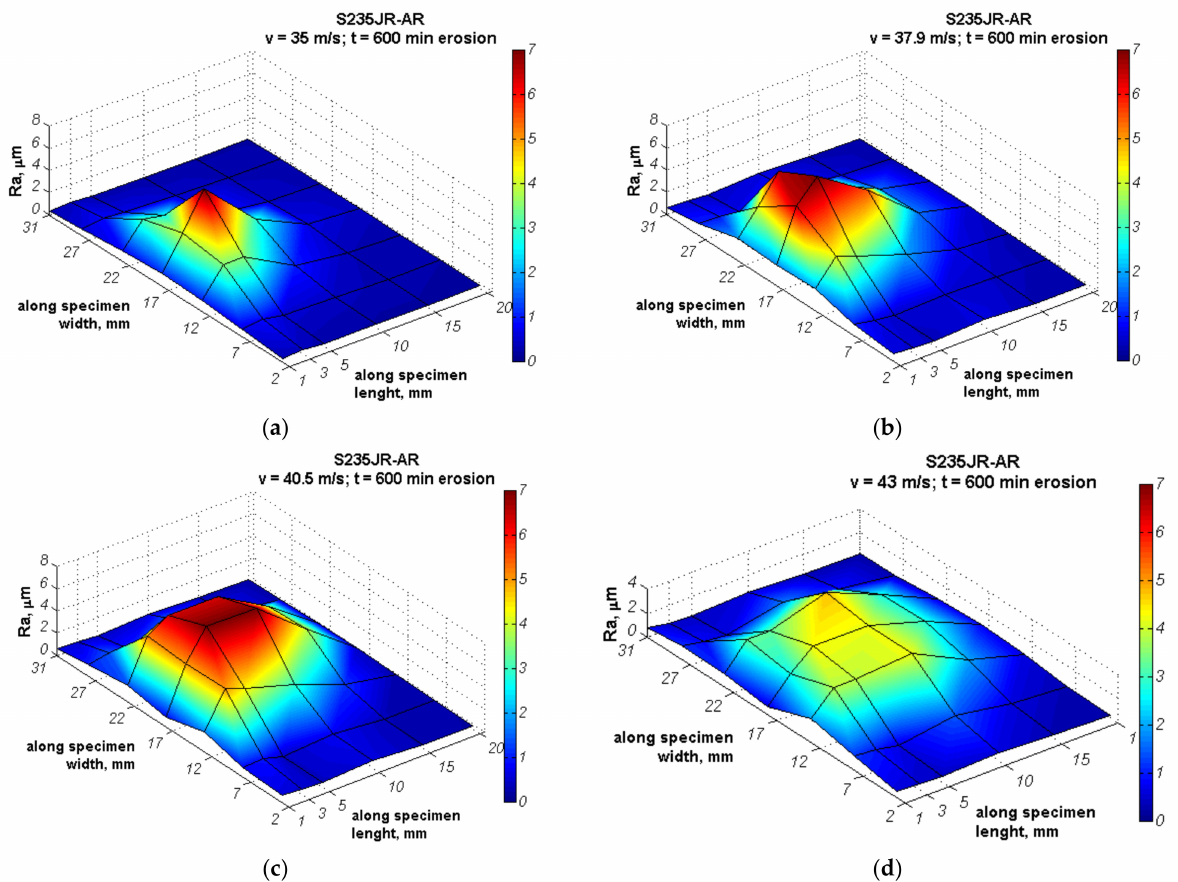
Figure 12. Distribution of the Ra parameter on the surface of the S235JR-AR steel tested for resistance to cavitation erosion at a flow velocity of ( a ) 35 m/s, ( b ) 37.9 m/s, ( c ) 40.5 m/s and ( d ) 43